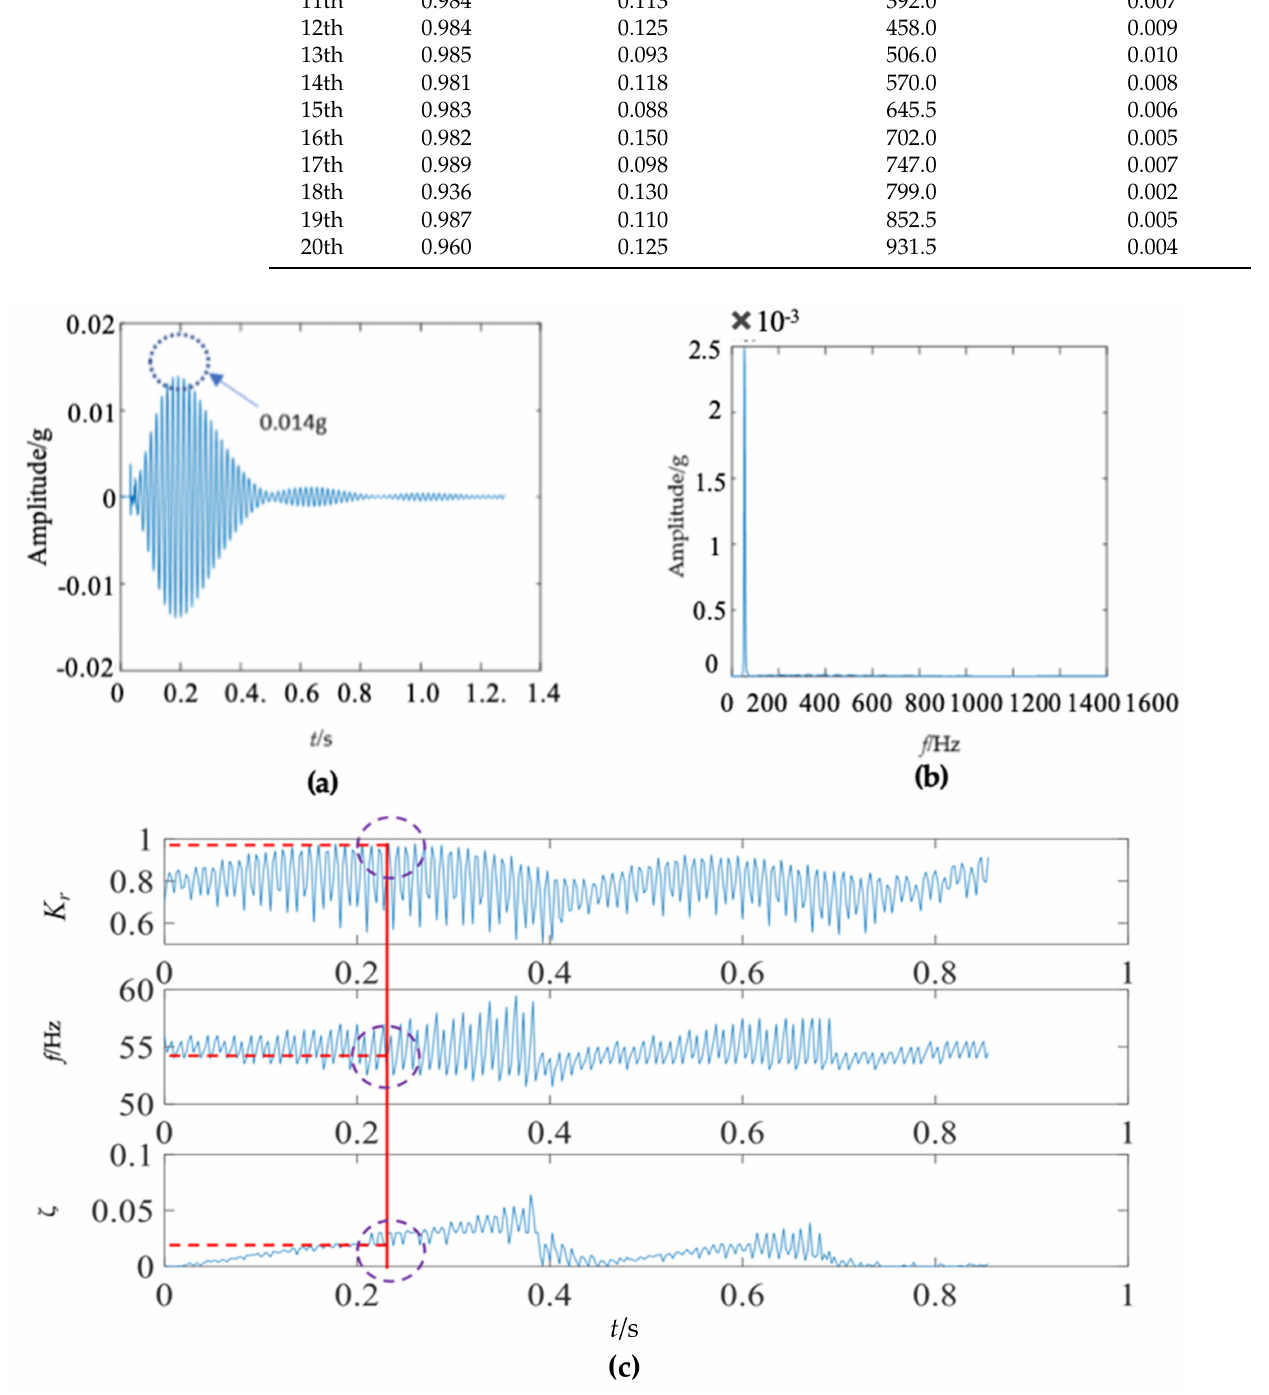
Figure 13. Second mode in the vibration response signal of the wooden utility pole labeled as 244984: ( a ) the vibration response of the second mode in the time domain, ( b ) the frequency spectrum of the second mode, and ( c ) the results of Laplace wavelet correlation filtering of the second